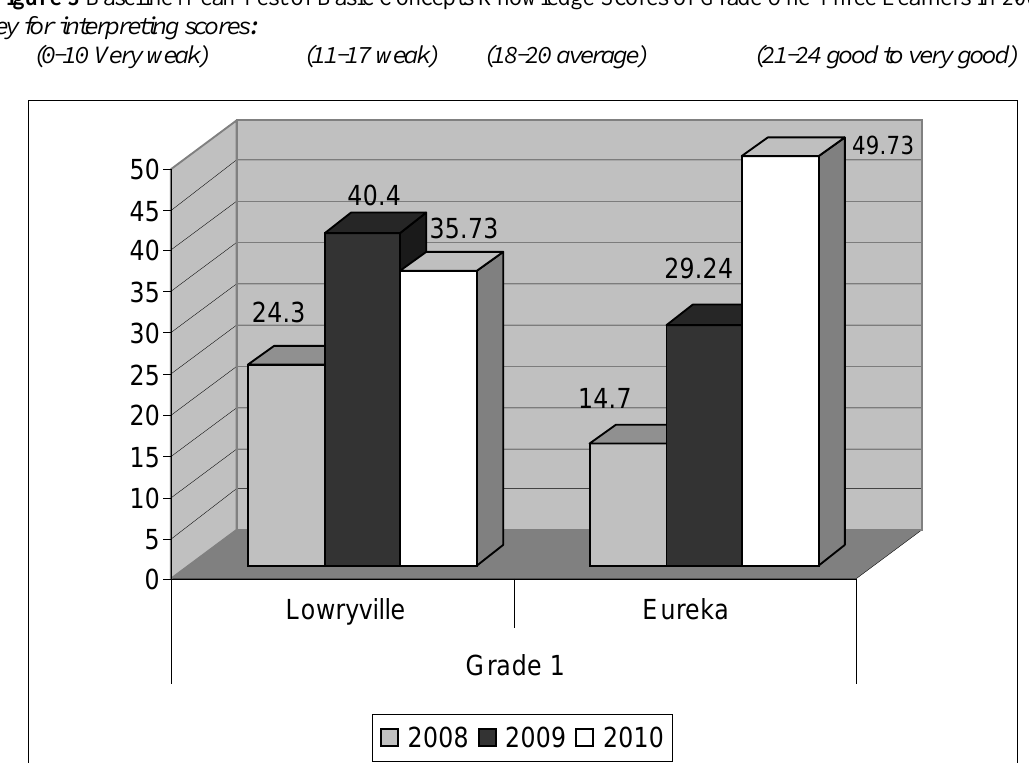
Figure 3 Baseline Mean Test of Basic Concepts Knowledge Scores of Grade One-Three Learners in 2008.